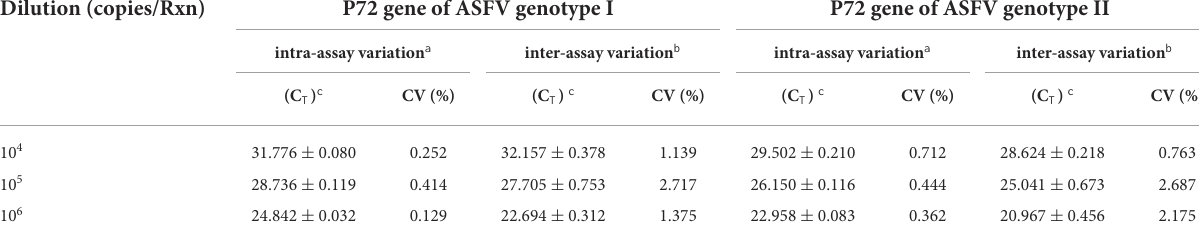
TABLE 2 Repeatability evaluation of the duplex real-time PCR for intra-assay and inter-assay variation. Dilution (copies/Rxn) P72 gene of ASFV genotype I P72 gene of ASFV genotype II intra-assay variation a inter-assay variation